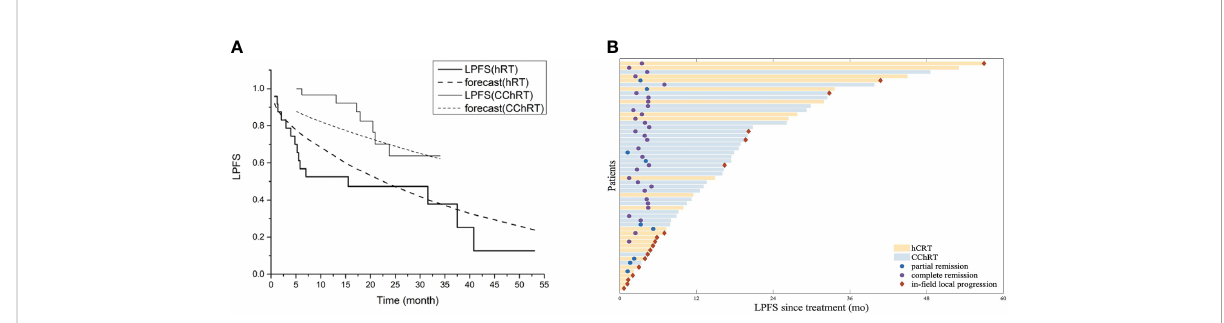
FIGURE 2 (A) Model forecast of in- fi eld LPFS data of CChRT group and hRT group using the LQRGC model (n=54). (B) Swimmer plots of in- fi eld LPFS for patients in CChRT group and hRT group (n=54). LPFS, loco-regional progression-free survival; DP, docetaxel-nedaplatin; CChRT, hypo- fractionated radiotherapy and concurrent chemotherapy; hRT, hypo-fractionated radiotherapy; LQRGC, the Linear Quadratic model with effects of four ‘‘ R ” s, Gompertzian tumor growth and chemotherapeutic agent.